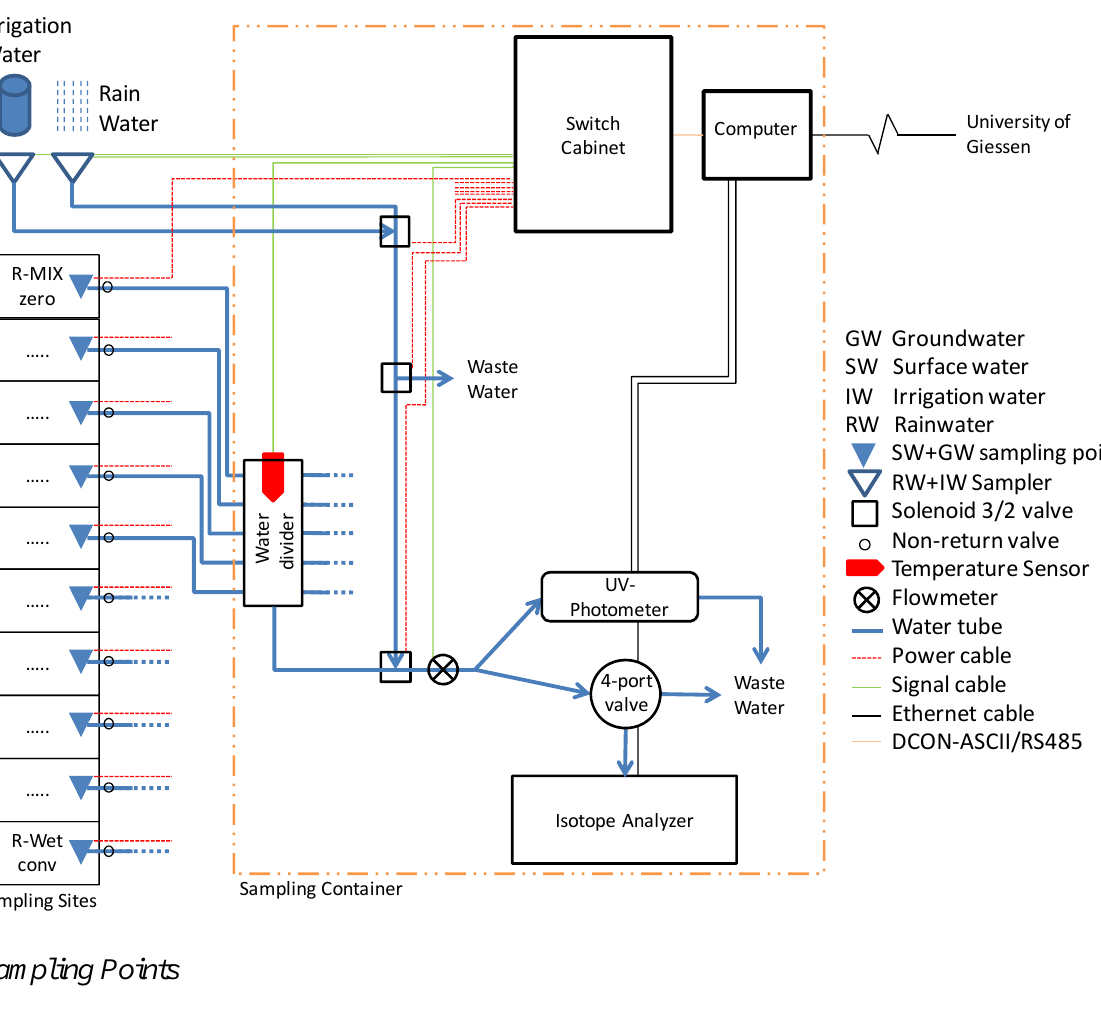
Figure 2. Technical set-up of the automatic water sampling system (container two) with a subset of ten plots: three water management schemes (R-WET, R-MIX and M-MIX) and three different fertilization practices (zero-N, site-specific and conventional), equipped with sampling stations for GW and SW sampling. These sampling stations provide a sample stream to the analytical equipment for in situ measurements of stable water isotopes (L2120- i Picarro) and nitrate (ProPS